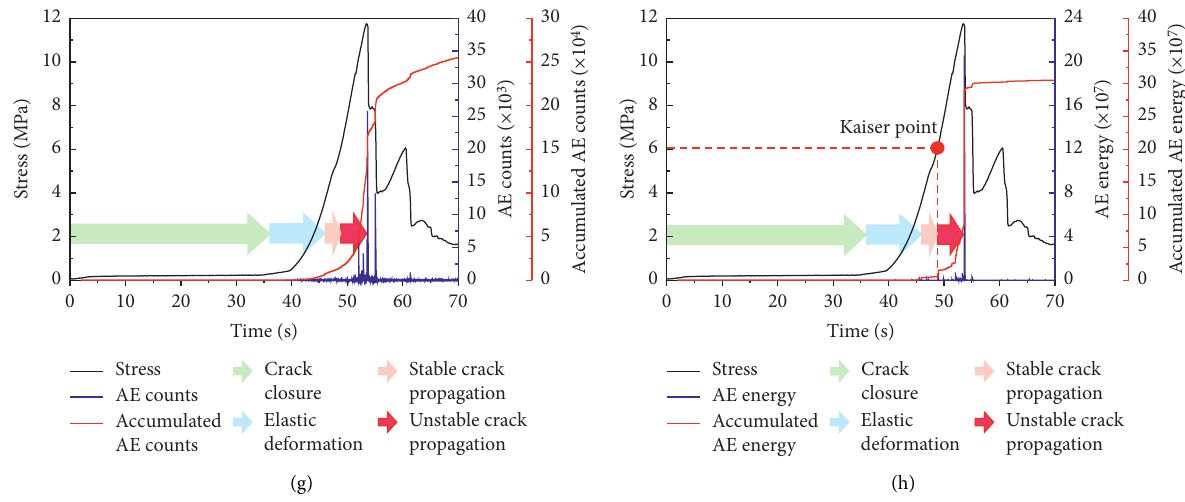
Figure 7: AE counts-AE energy-stress-time curves under different loading rates: (a) AE counts-stress-time curves when the loading rate is 5 × 10 − 7 m/s; (b) AE energy-stress-time curves when the loading rate is 5 × 10 − 7 m/s; (c) AE counts-stress-time curves when the loading rate is 5 × 10 − 6 m/s; (d) AE energy-stress-time curves when the loading rate is 5 × 10 − 6 m/s; (e) AE counts-stress-time curves when the loading rate is 1.7 × 10 − 5 m/s; (f) AE energy-stress-time curves when the loading rate is 1.7 × 10 − 5 m/s; (g) AE counts-stress-time curves when the loading rate is 5 × 10 − 5 m/s; (h) AE energy-stress-time curves when the loading rate is 5 × 10 − 5